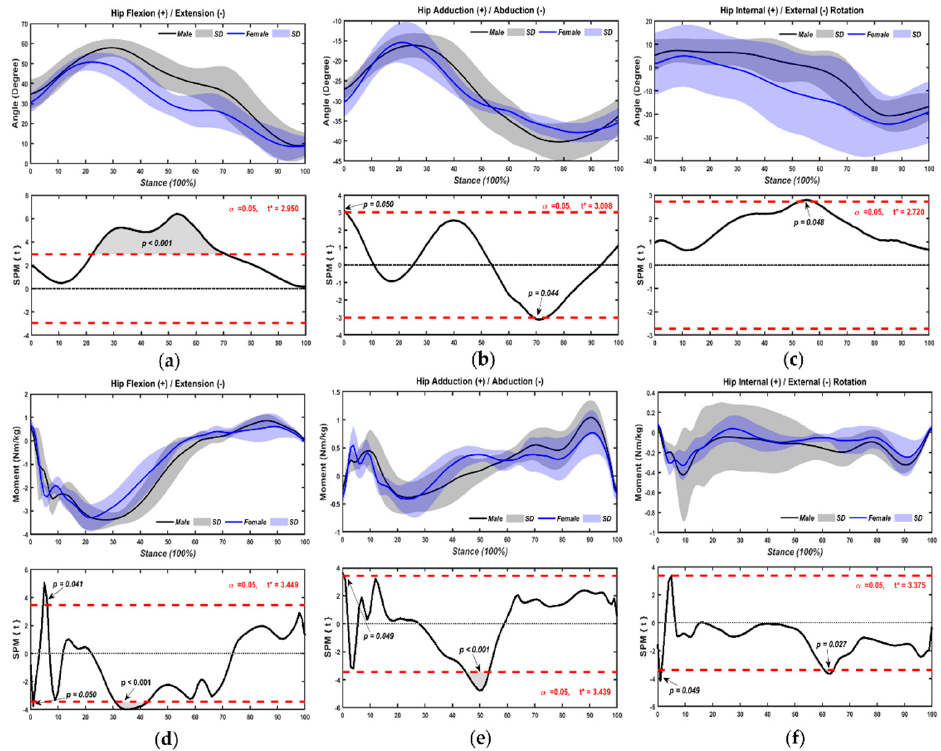
Figure 4. Kinematics (( a ), flexion/extension angle; ( b ), adduction/adduction angle; ( c ), internal/external rotation angle) and kinetics (( d ), flexion/extension moment; ( e ), adduction/abduction moment; ( f ), internal/external rotation moment) of hip joint with chasse-step in sexes.